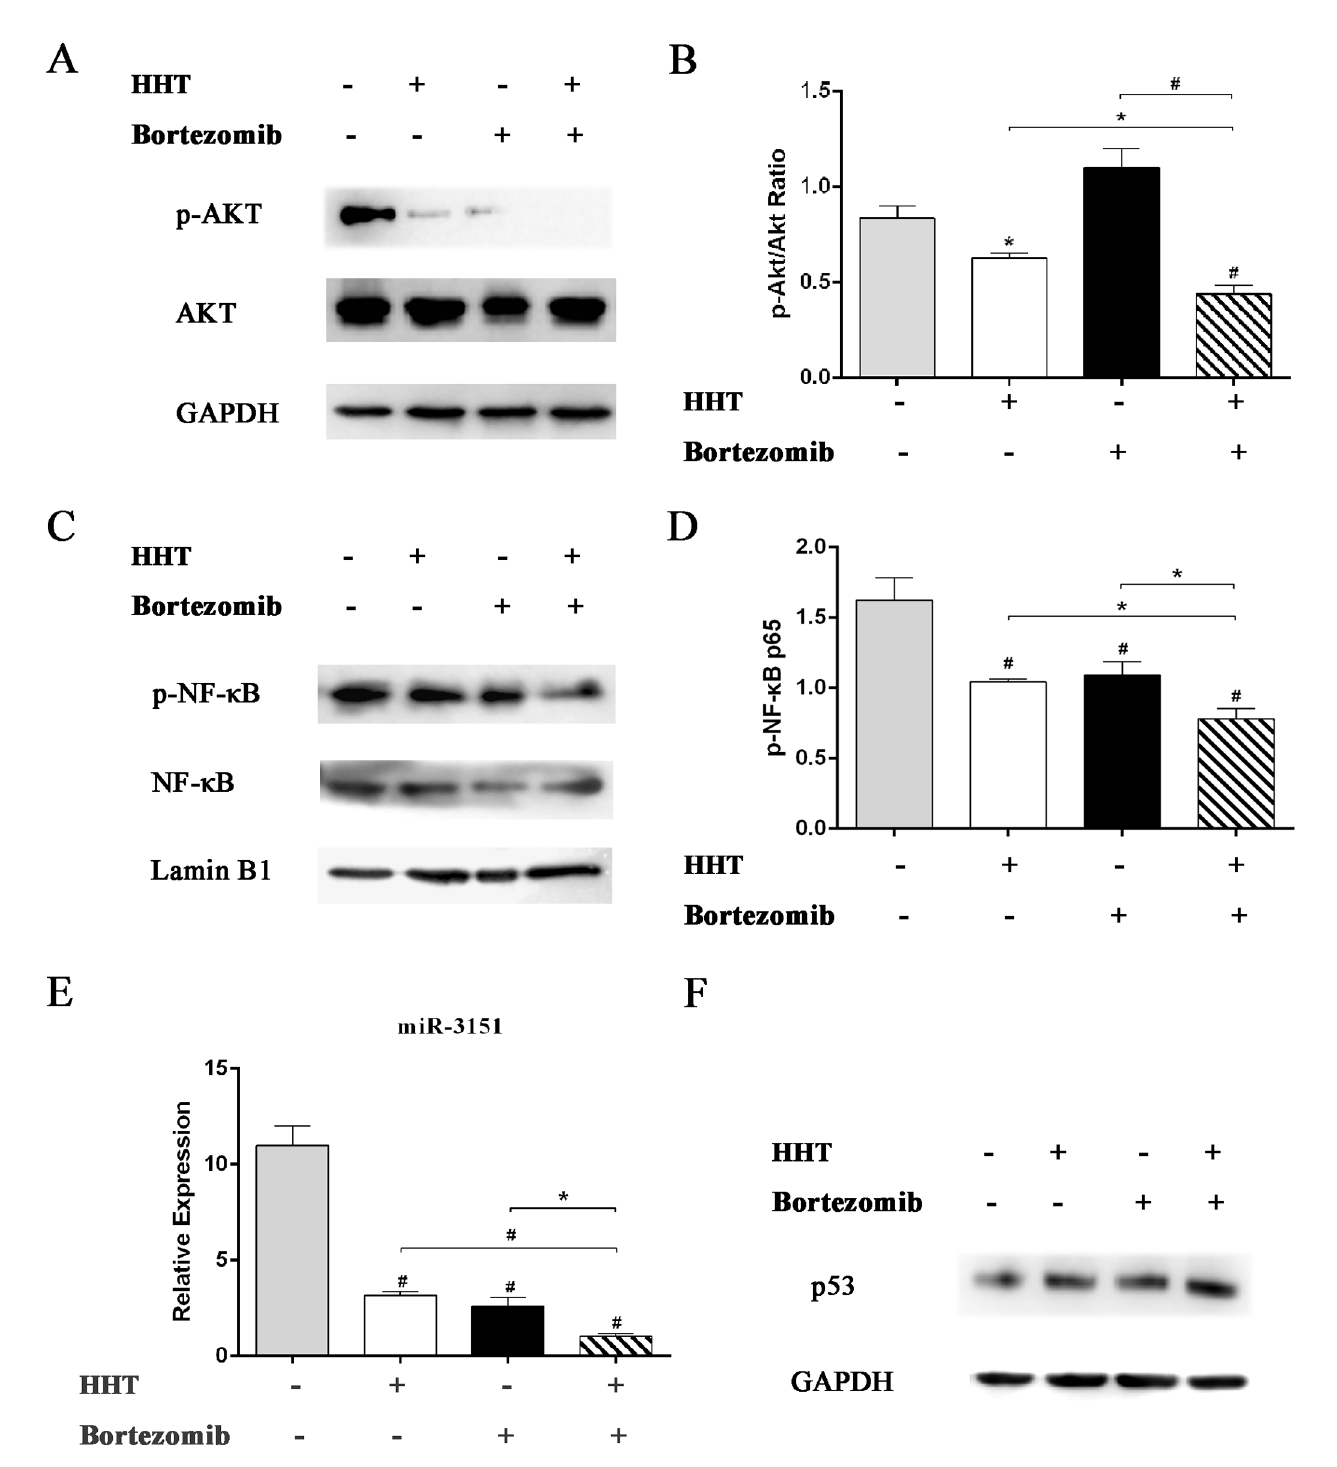
Fig 6. Effects of HHT or Bortezomib on Akt and NF- κ B signaling pathway. Western blot analyses of p-Akt, Akt (A and B), p-NF- κ B, NF- κ B (C and D) and p53 (F) protein expression in SKM-1 cells exposed to 11.55 nM HHT or 1.12 nM Bortezomib for 72 h. (E) Real-time PCR detection of miR-3151 expression level in SKM-1 cells exposed to 11.55 nM HHT or 1.12 nM Bortezomib for 6 h. * P < 0.05, #P < 0.01 vs untreated control.